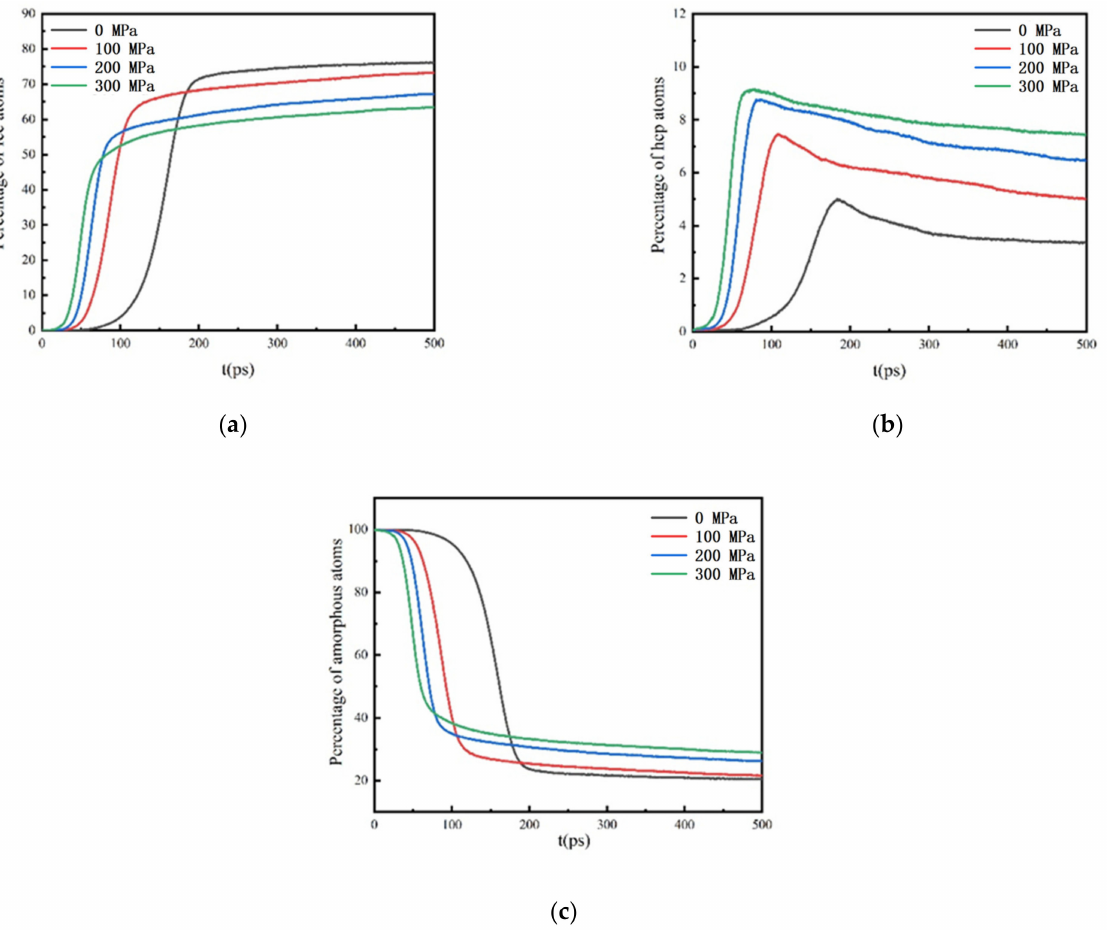
Figure 5. Time dependence of atomic fractions for ( a ) FCC, ( b ) HCP and ( c ) the “other” structures during the isothermal-solidification process under different